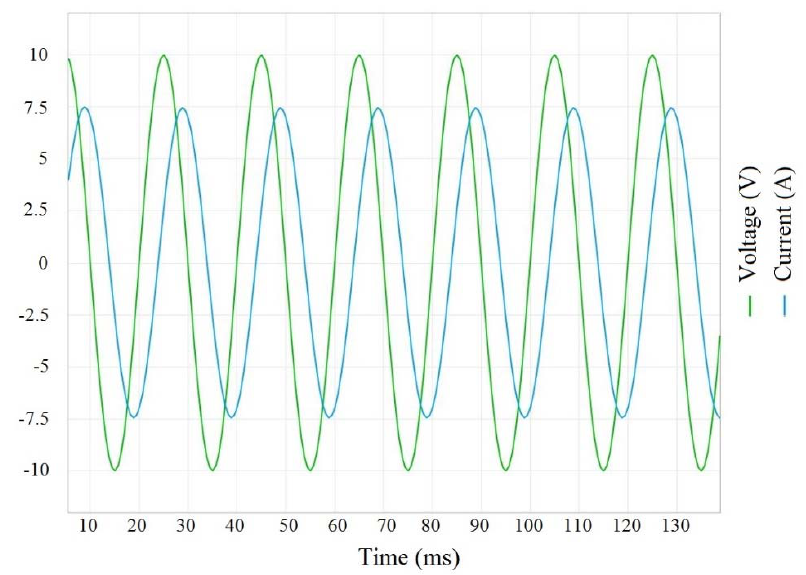
Figure 15. The PMSM stator voltage and current signals achieved in the simulation model (where the current signal stayed behind the voltage signal).